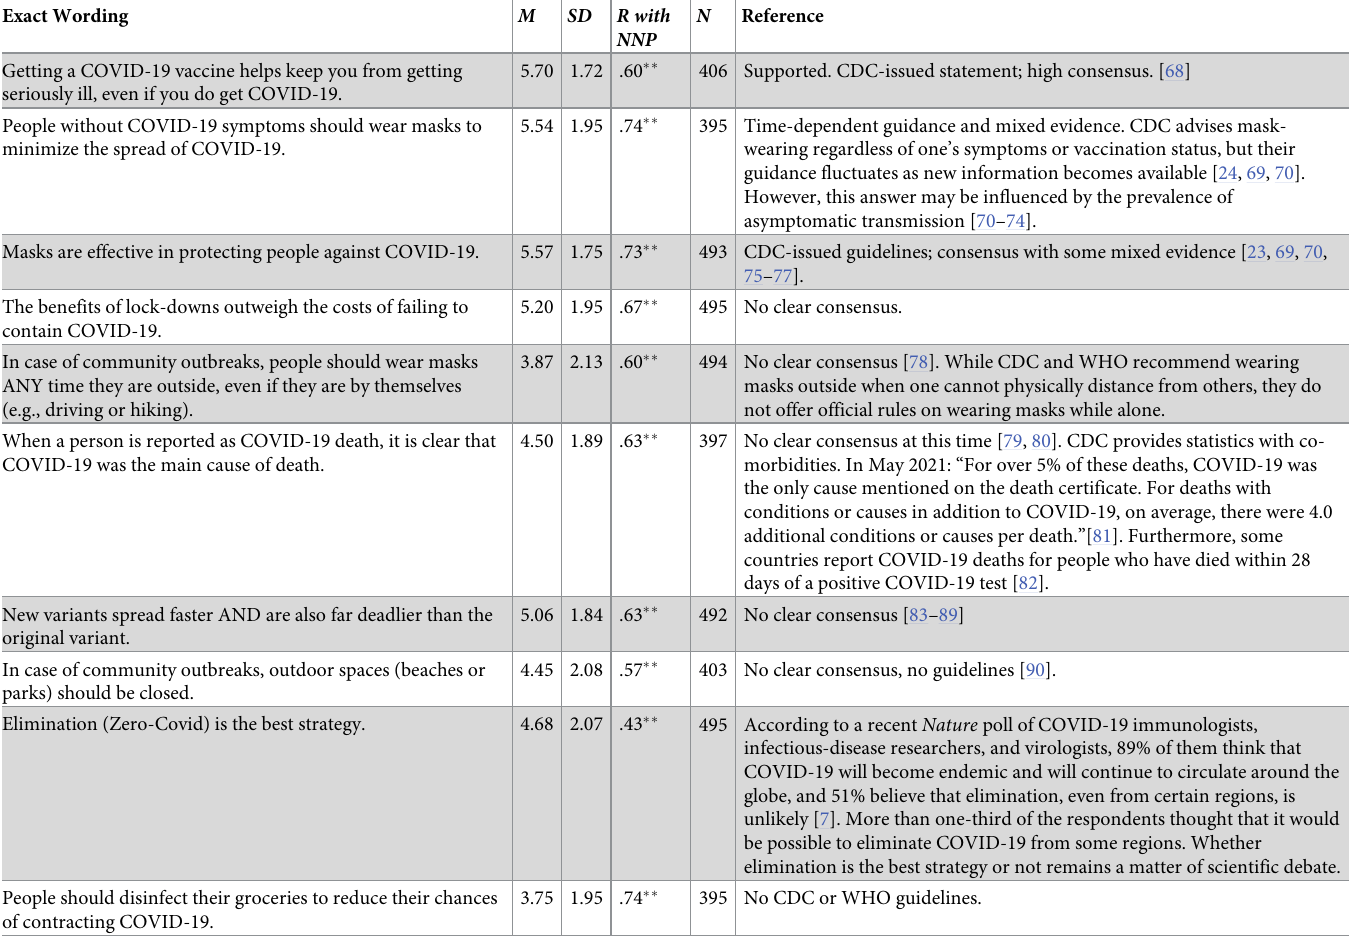
Table 5. Perceived scientific evidence of COVID-19 risks items and correlations with NNP (Samples A–D; 2021). Exact Wording M SD R with